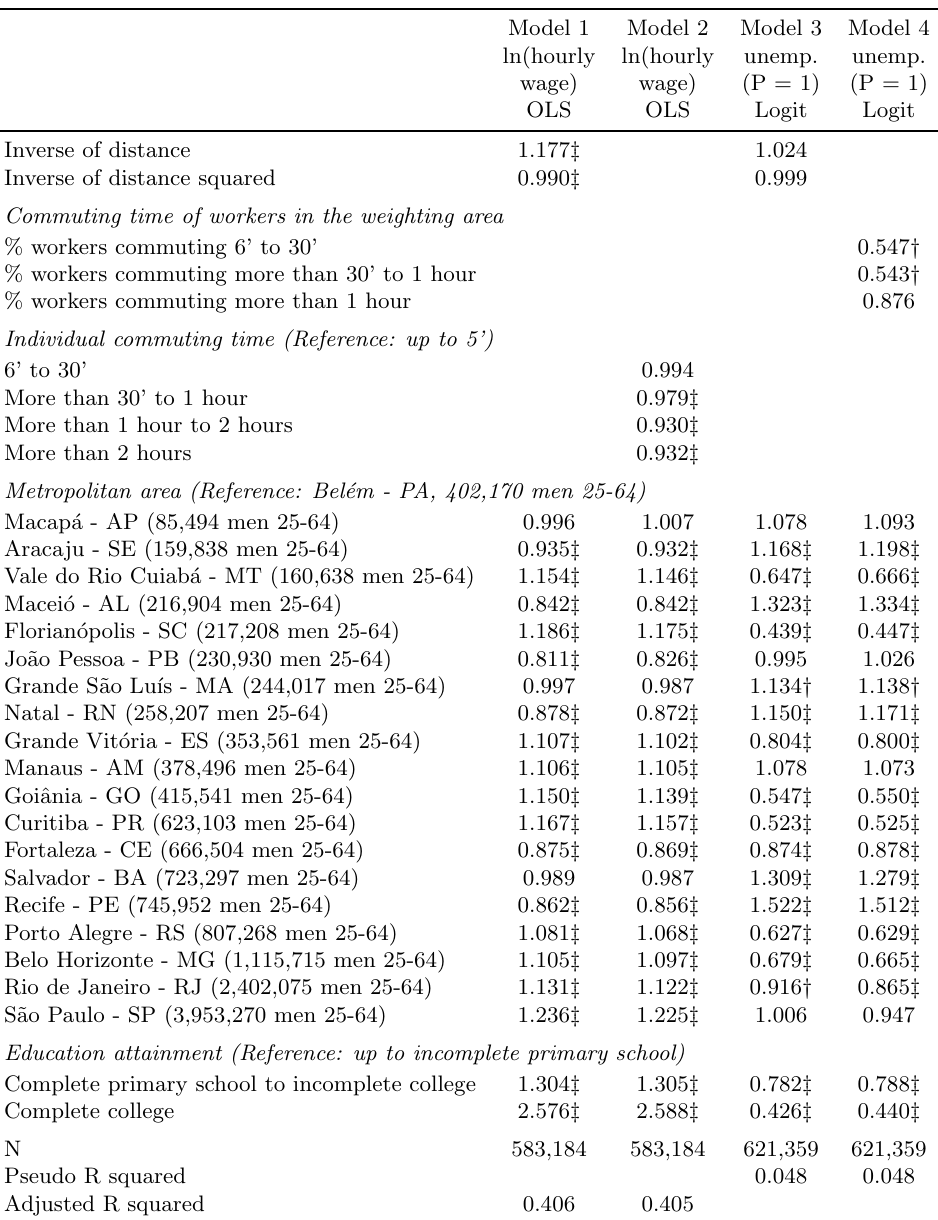
Table A.4: Regressions for the whole database Model 1 Model 2 Model 3 Model